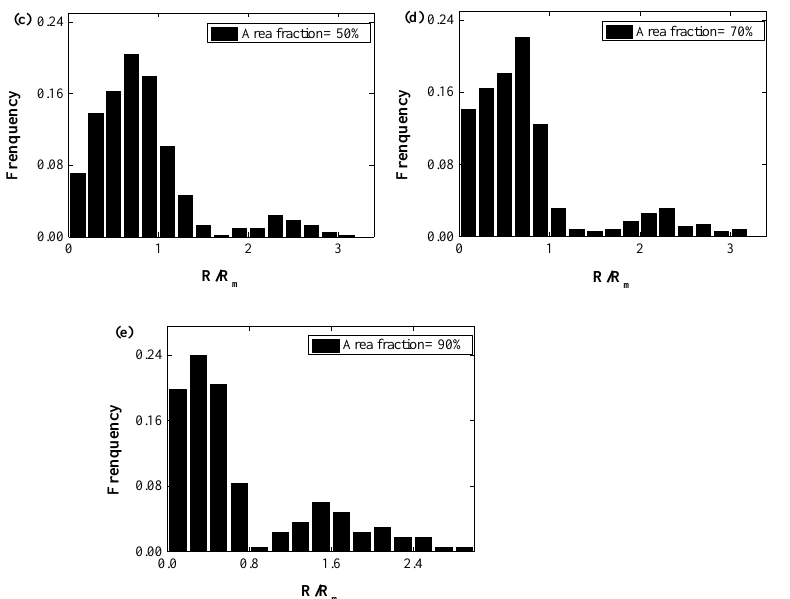
Figure 13. Grain size distribution with initial 47 Type II grains at different area fractions: ( a ) 10%, ( b ) 30%, ( c ) 50%, ( d ) 70%, and ( e ) 90%.